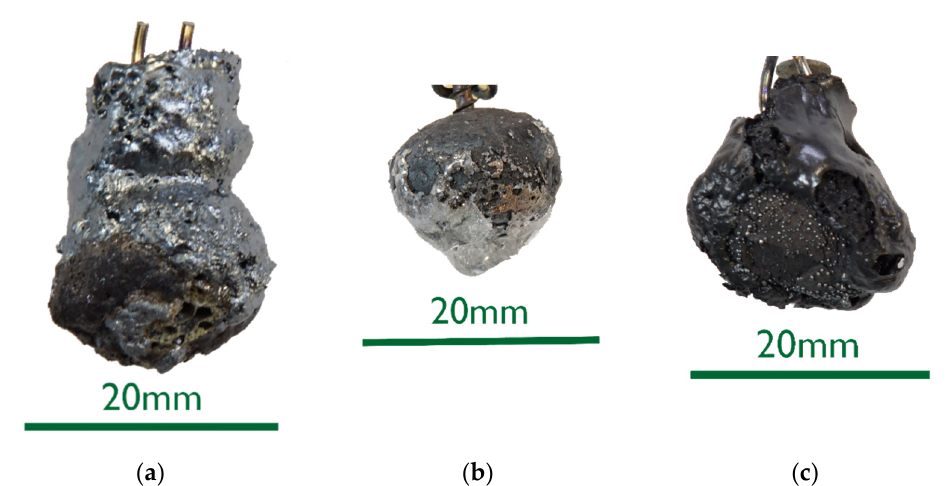
Figure 4. Macroscopic photograph of the sample C750-ULC-3.